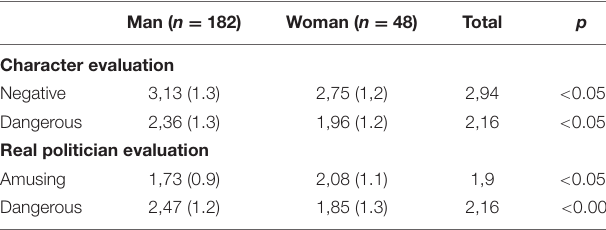
TABLE 6 | Descriptive statistics of character and real politician evaluation ∗ Parodied politician’s gender (mean and SD).